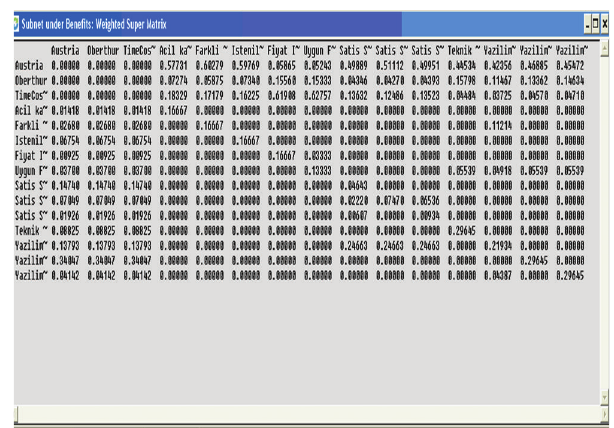
Figure 9: Weighted super matrix.